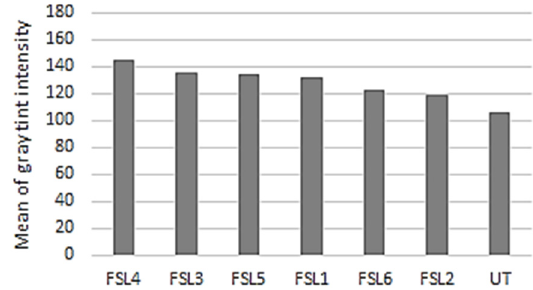
Figure 8. The shade of grey diagram.